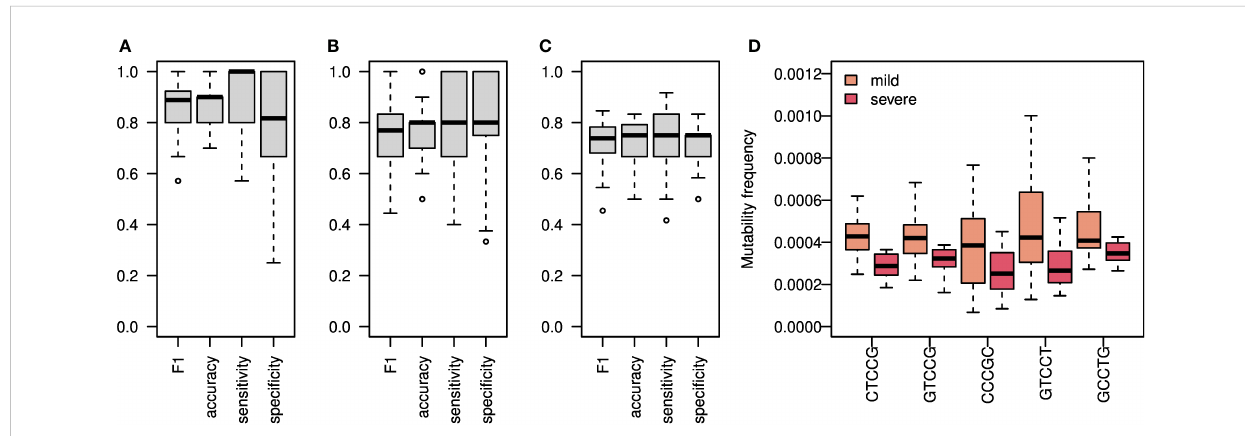
FIGURE 4 SHM Heavy chain enables classi fi cation of both SARS-CoV2 infection and COVID-19 severity. (A) An ML algorithm was trained on the substitutions matrix of the 5-mer SHM model, which was created for the IGA/G isotypes. Boxplots representing F1 score, accuracy, speci fi city, and sensitivity of 50 random splits to train and test groups are shown. (B) The same algorithm as in A was trained on silent mutations only. Shown are Boxplots representing the F1 score, accuracy, speci fi city, and sensitivity of 50 random splits to train and test groups. (C) Boxplots showing F1 score, accuracy, speci fi city, and sensitivity of 20 leave-one-out cross validation of severity classi fi cation. Each leave-one-out was on 12 severe COVID-19 patients and 12 randomly selected mild COVID-19 patients. The ML algorithm was trained on the mutability matrix of the SHM cold-spots in these groups. (D) Frequency of mutability in mild and severe individuals with COVID-19. Boxplots of frequencies of repeating coef fi cients of the algorithm explained in (C) are